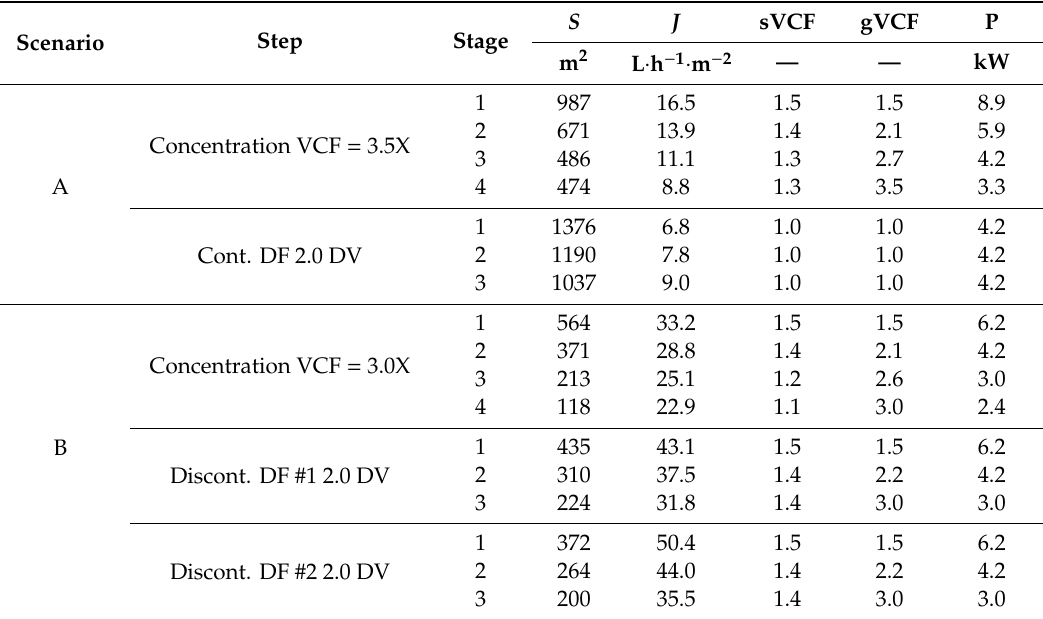
Table 5. Dimensioning of the filtration systems for scenarios A and